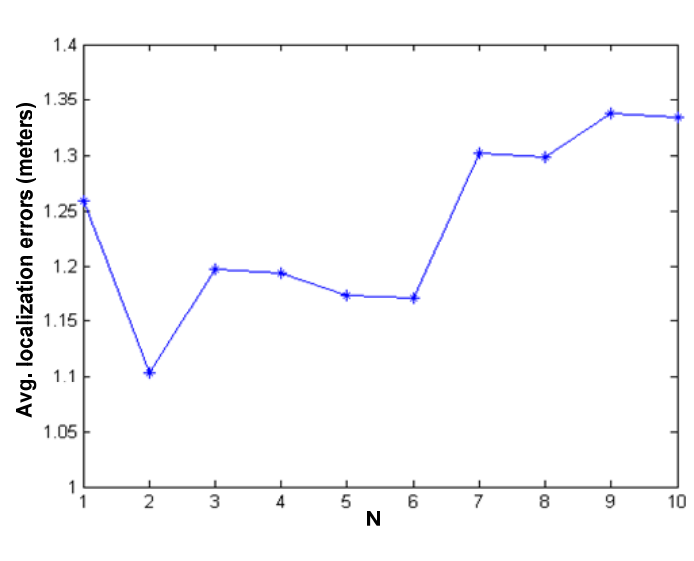
Figure 2. Localization errors due to N.